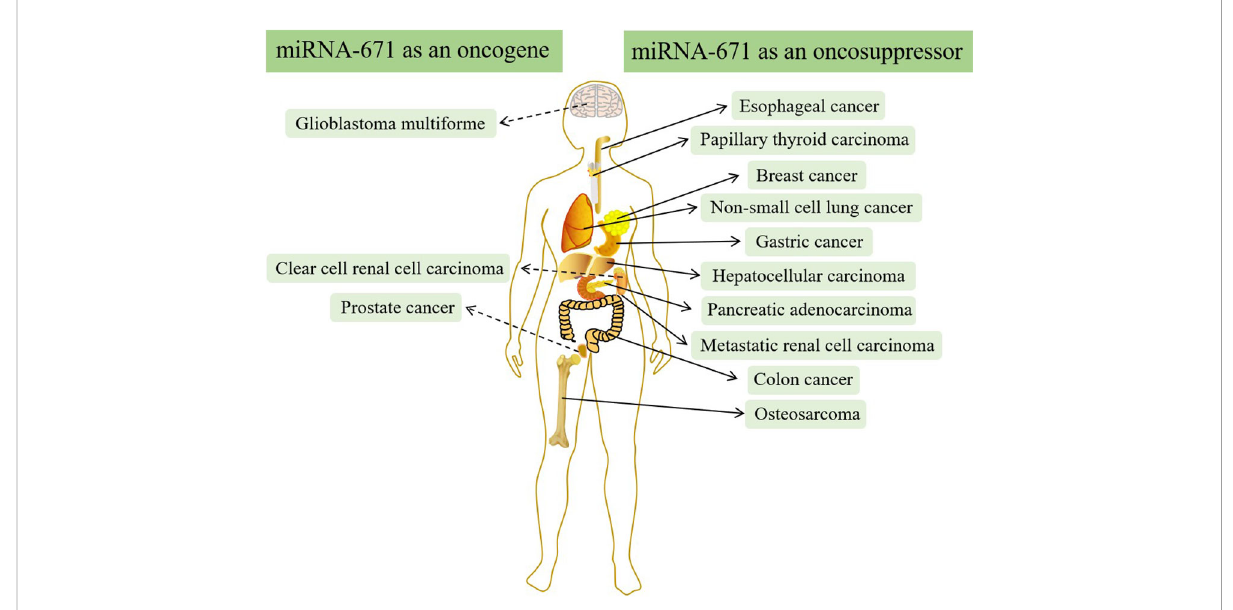
FIGURE 5 miRNA-671 in different types of